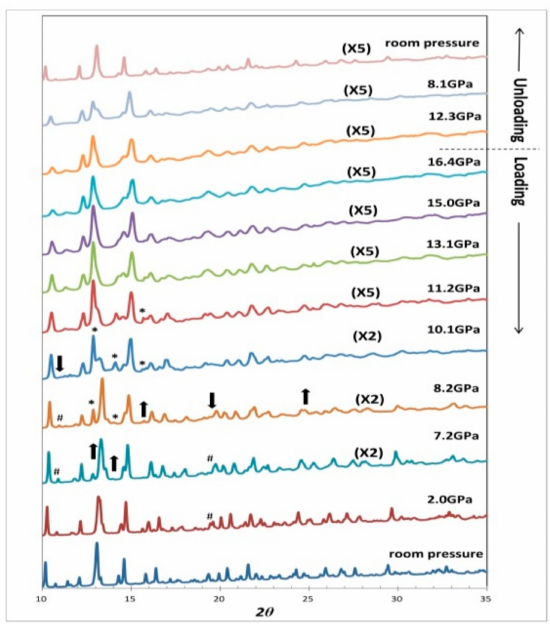
Figure 3. A series of X-Ray Diffraction patterns showing the sequences of phase transitions in scottyite during the loading and unloading processes. Scottyite exhibits four new peaks above 7–8 GPa (indicated by “ ↑ ” and “*”) suggesting the onset of phase transition. In addition, some peaks disappeared or merged (indicated by “ ↓ ” and “#”) when the pressure is over 10 GPa. The scottyite phase was recovered during the unloading